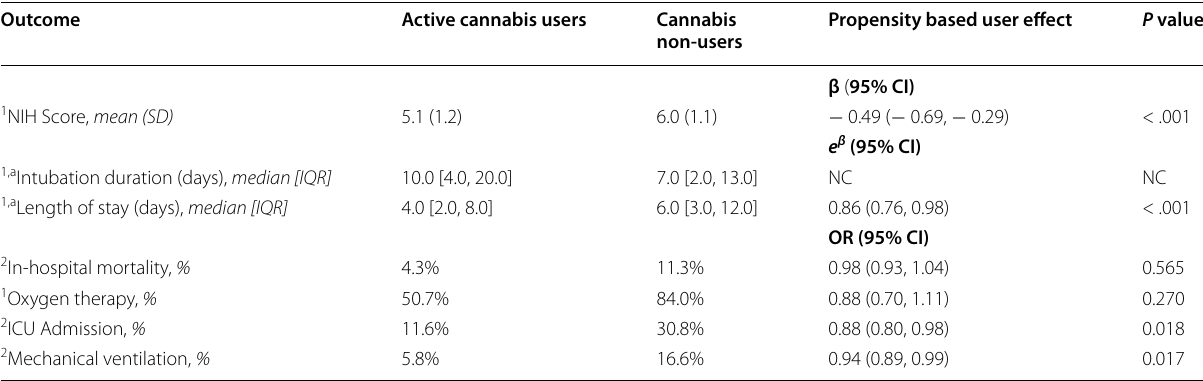
Table 2 Propensity-matched outcomes comparing active cannabis users and